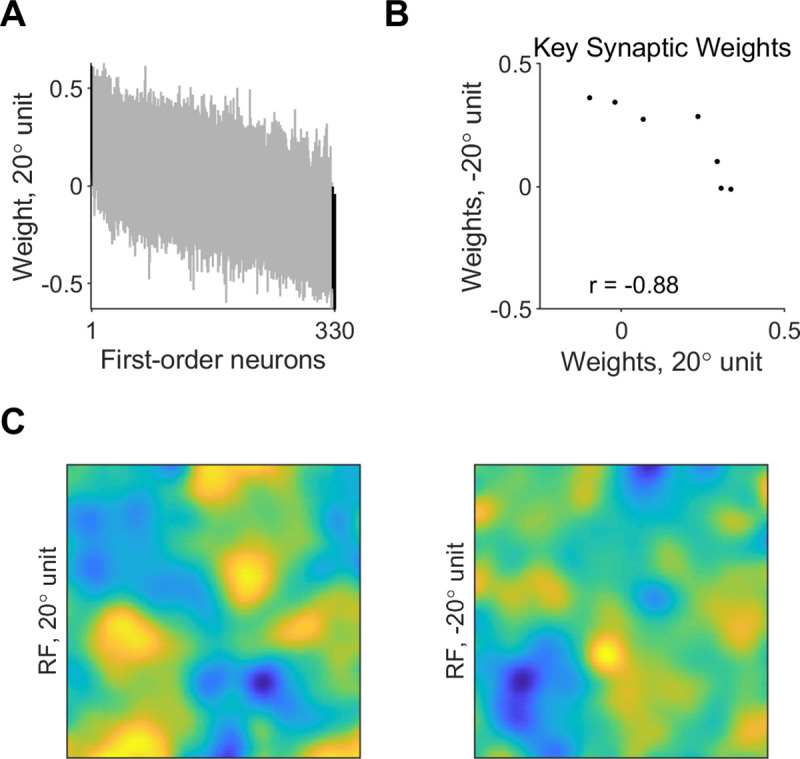
Synaptic weights and receptive field of slow-decaying (NMDA) edge-orientation classifiers.A. Synaptic weights from model first-order neurons onto classifier units using slow-decaying (NMDA) synapses and tuned to 20°, with presentation time window of 50 ms and noise level 5%. Shown are 95% confidence intervals of weights over 20 classifiers. Synaptic weights are shown in decreasing order of average weight over the 20 classifiers. Black–key synaptic weights, which were significantly different than 0. B. Key excitatory synaptic weights in example classifier units using NMDA synapses and tuned to 20 vs -20°. C. Spatial layout of the synaptic weights in classifier units using NMDA synapses and tuned to -20 or 20°, with presentation time window of 50 ms and noise level 5%. Receptive fields represent averages over 20 classifiers.